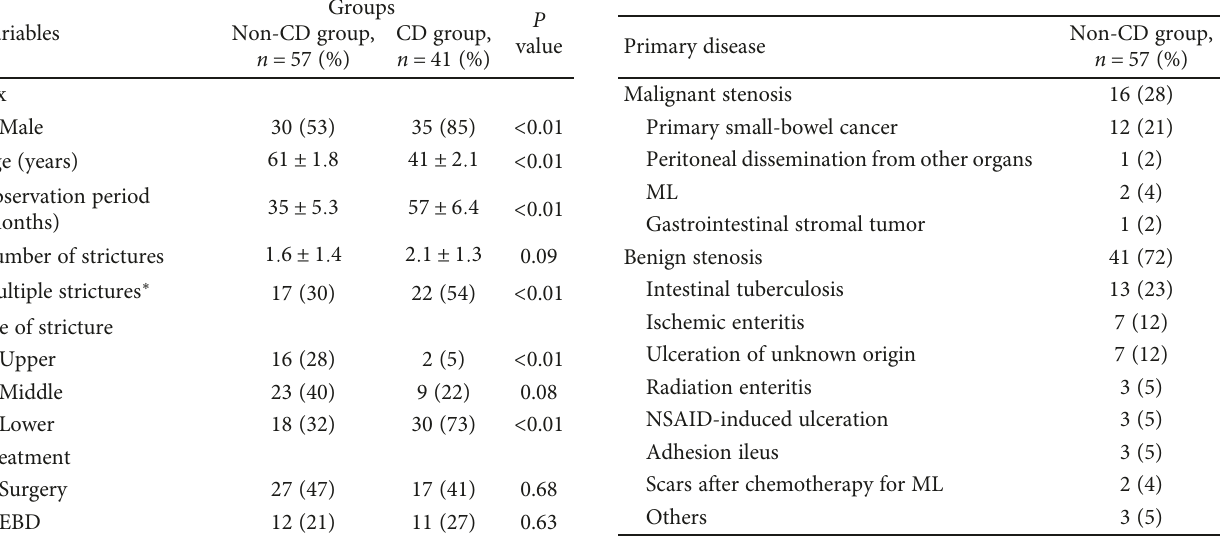
Figure 2: Initial treatment for small-bowel strictures. Surgery was selected as the initial treatment in 27 cases of the non-CD group (47%) and 17 cases of the CD group (41%). In total, surgery was selected as the initial treatment in 44 cases (45%). In the surgery cases of the non-CD group, 14 patients (52%) had strictures due to malignant tumor. EBD was performed in 23 cases (23%) overall as the initial treatment. Twelve cases (21%) and 11 cases (27%) had EBD performed as the initial treatment in the non-CD and CD groups, respectively EBD: endoscopic balloon dilation. Table 1: Clinical characteristics of all cases. Table 2: Primary diseases of the small-bowel strictures in the non- Crohn ’ s disease